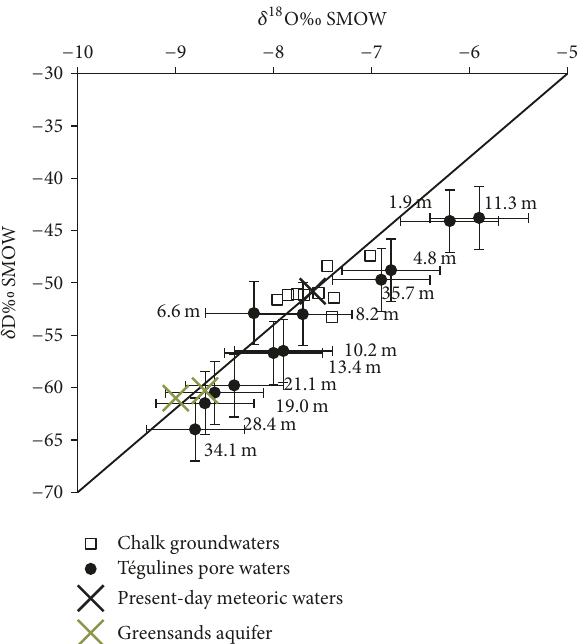
Figure 9: 𝛿 18 O- 𝛿 D diagram in which the T´egulines waters, the meteoric water line (MLW), local present-day meteoric waters [29], and Greensand aquifer (Bougligny) [30] are